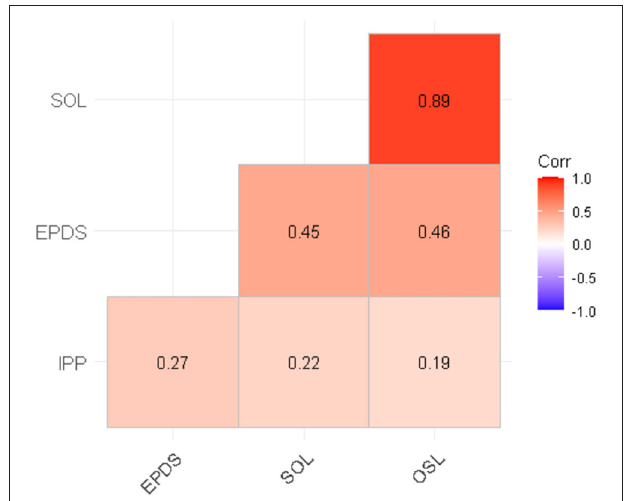
FIGURE 2 | Correlation between IPP, EPDS and PSS:NICU SOL and OSL scores. All correlations were significant ( p < 0.05). PSS:NICU, Parental Stressor Scale in the NICU; SOL, Stress Overall Level; OSL, Overall Stress Level; EPDS, the Edinburgh Postnatal Depression Scale; IPP, Index of Parenteral